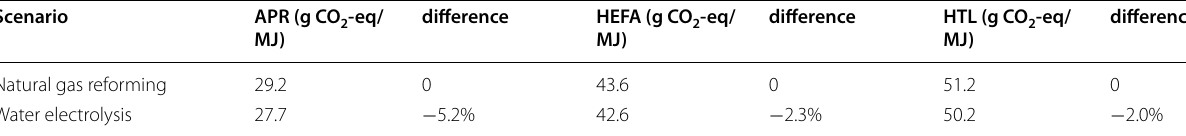
Table 7 Sensitivity analysis on hydrogen input